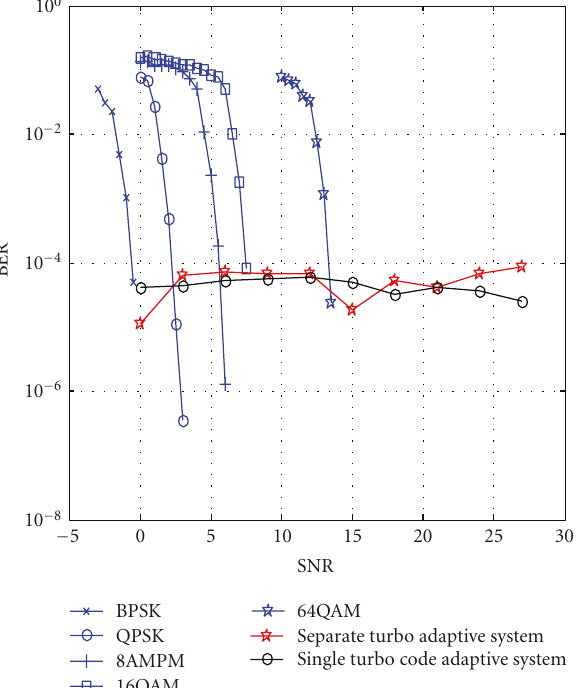
Figure 12: BER of separate turbo code system and one turbo code system with BER target 10 − 4 .